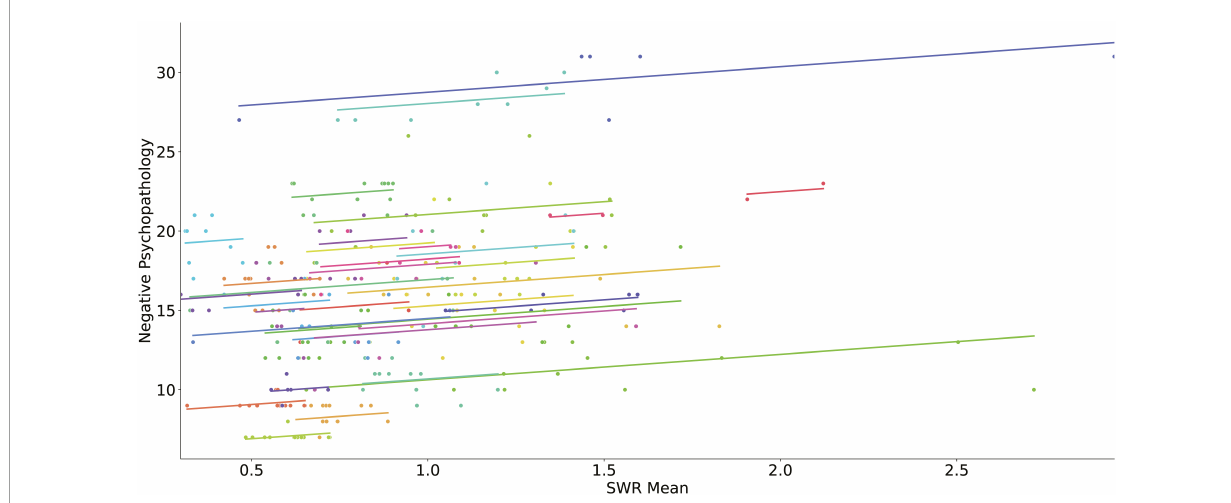
FIGURE5 Scatter plot of the relation of SWR and negative psychopathology (negative PANSS score). Each subject’s data as well as the predicted linear model line are presented with a different color.